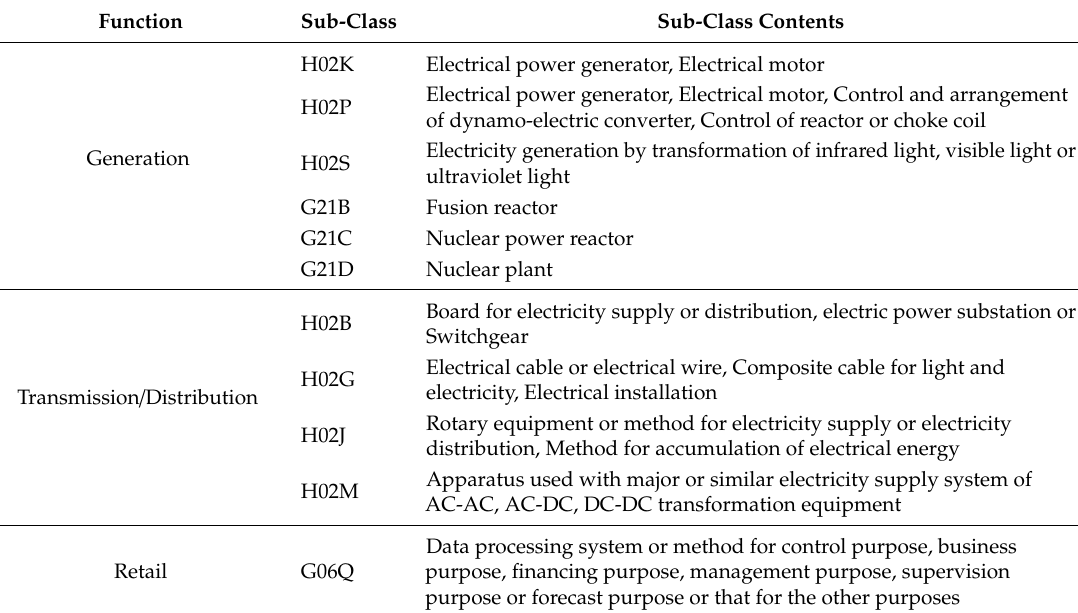
Table 1. A list of sub-classes of patents analyzed in this